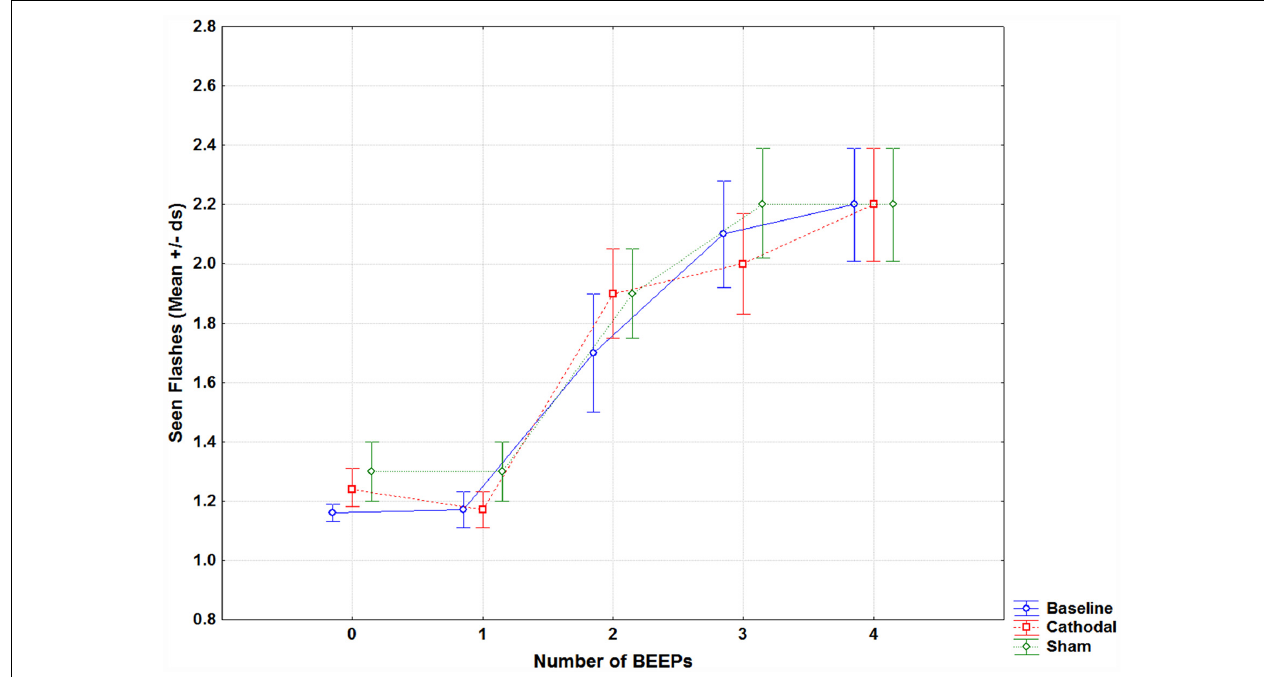
FIGURE 2 | Mean seen flashes in fission trials (1 flash combined with 0 to 4 beeps) reported by patients with migraine in the baseline (without tDCS, blue line), during cathodal occipital (red line) and sham tDCS (green line).